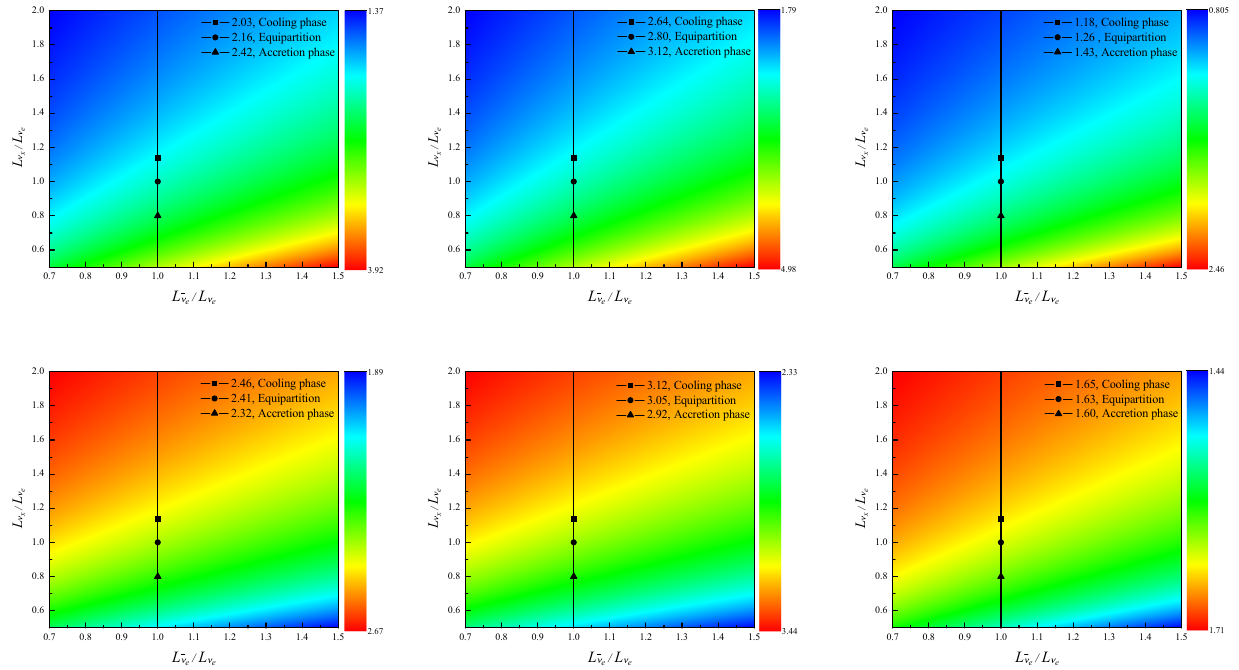
>,< E ¯ ν >,< E ν >) taken e e x / L ν < 1 . 5 and e e